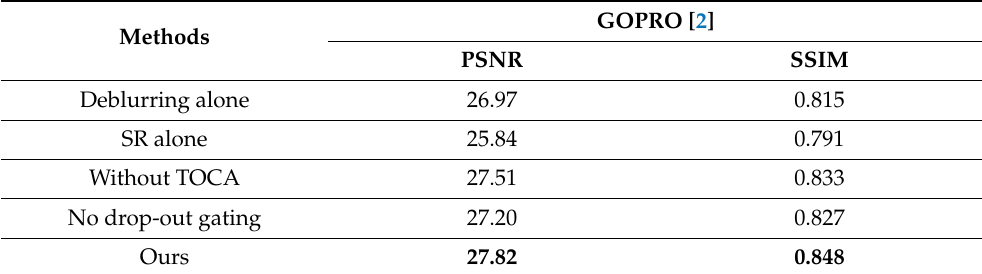
Table 4. Ablation study on GOPRO [2] dataset. The best results are indicated in bold.